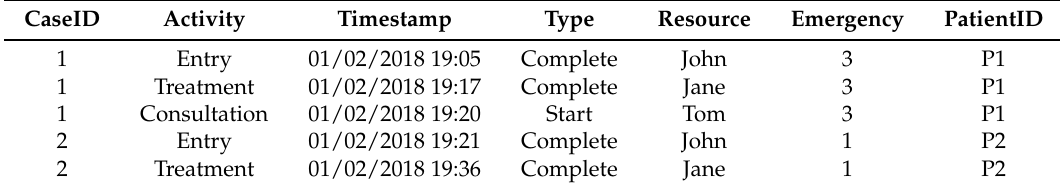
Table 1. A snippet of the emergency room (ER) event log.